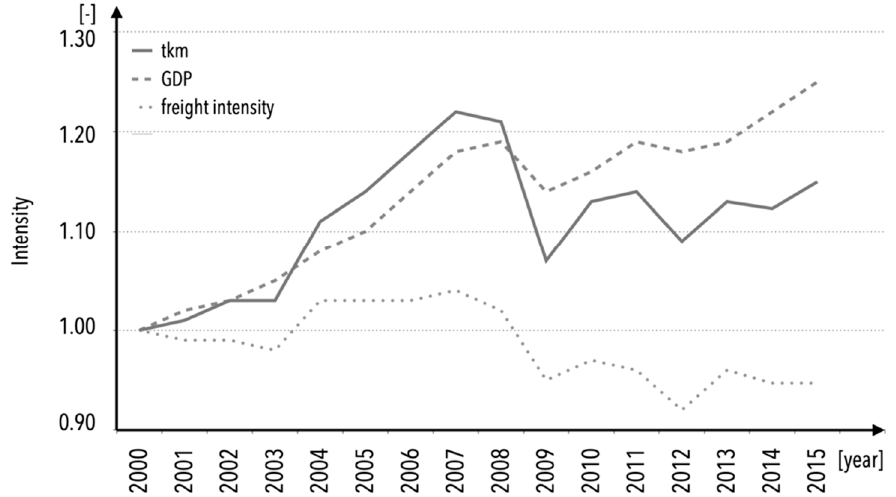
Figure 1. Inland freight transport volumes, based on EEA [3,4].